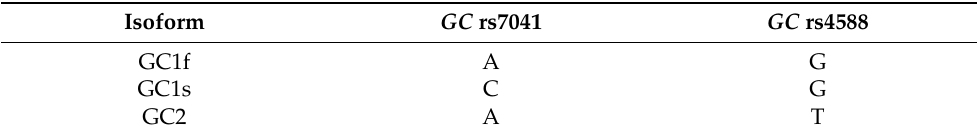
Table 1. Isoform genotype in rs7041 and rs4588.